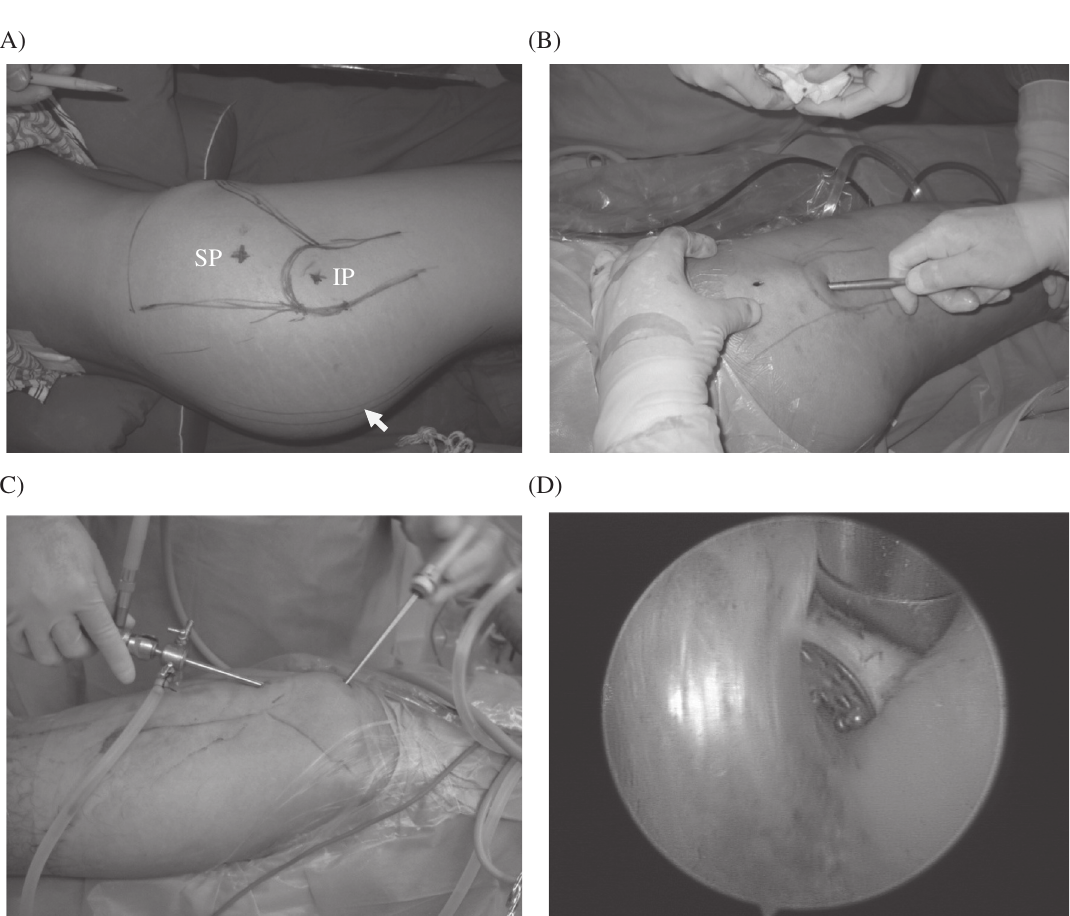
Figure 4. Endoscopic release of gluteal muscle contracture using two portals technique. (A) In neutral lateral position of the hip, important anatomical landmarks were drawn. IP represents inferior portal or viewing portal (3 cm distal to superior border of greater trochanter) whereas SP represents superior portal (5 cm proximal to IP) which is working portal; and an arrow points the course of sciatic nerve; (B) surgeon created an artificial working space; (C) represents endoscopic release of gluteal muscle contracture in lateral position and; (D) shows silvery white contracture